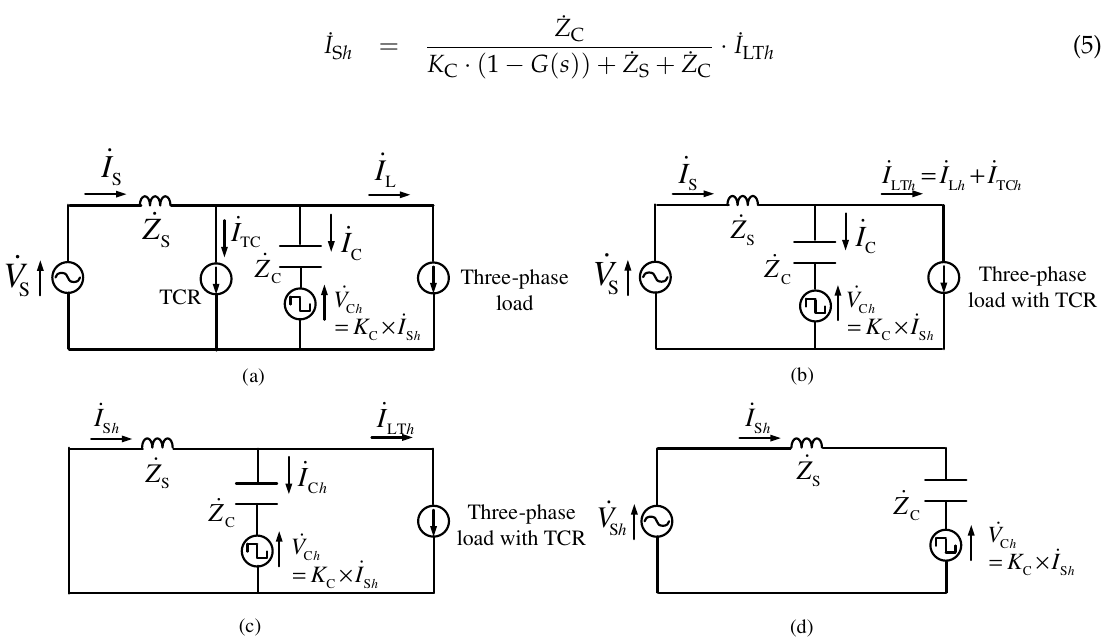
Figure 5. Per-phase equivalent circuits for Figure 4 with the control gain K C Ω . ( a ) Per-phase equivalent circuit. ( b ) Per-phase equivalent circuit for current-source harmonic-producing load. ( c ) Equivalent circuit for ˙ I LT h . ( d ) Equivalent circuit for ˙ V S h .